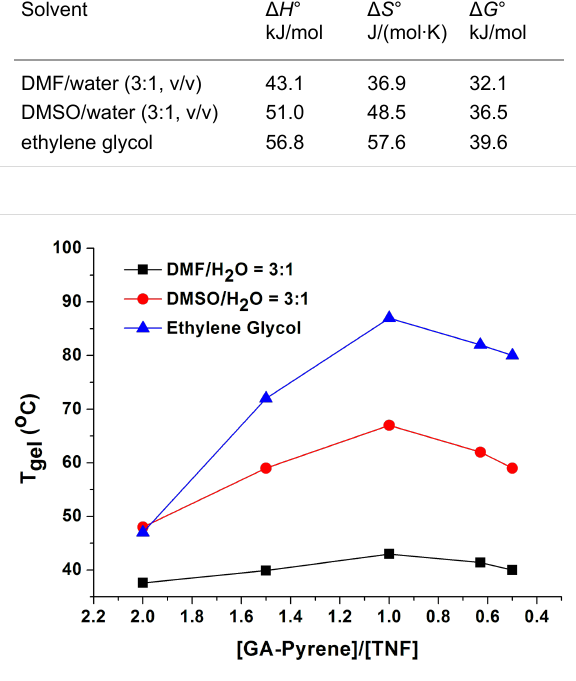
Figure 4: Scanning electron micrographs of CT xerogels ( 3 and 4 , 1:1, molar ratio, [ 3 ] = 9 mM) in DMSO/water (3:1, v/v) (a, b), ethylene glycol (c, d), and DMF/water (3:1, v/v) (e and f). Scale bars in are 20 μ m for (a, c, e) and 10 μ m for (b, d,